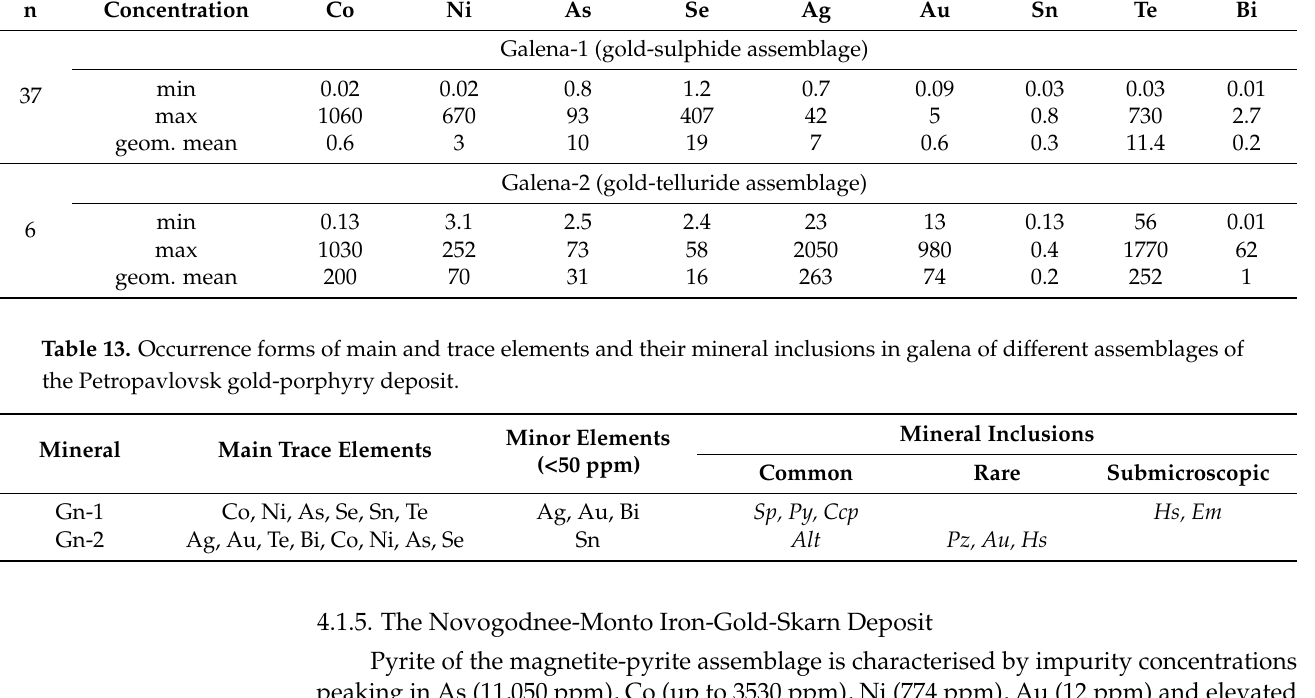
Table 12. The limits and average values of the contents of trace elements in galena (ppm) of different assemblages of the Petropavlovsk gold-porphyry deposit according to LA-ICPMS data. n Concentration